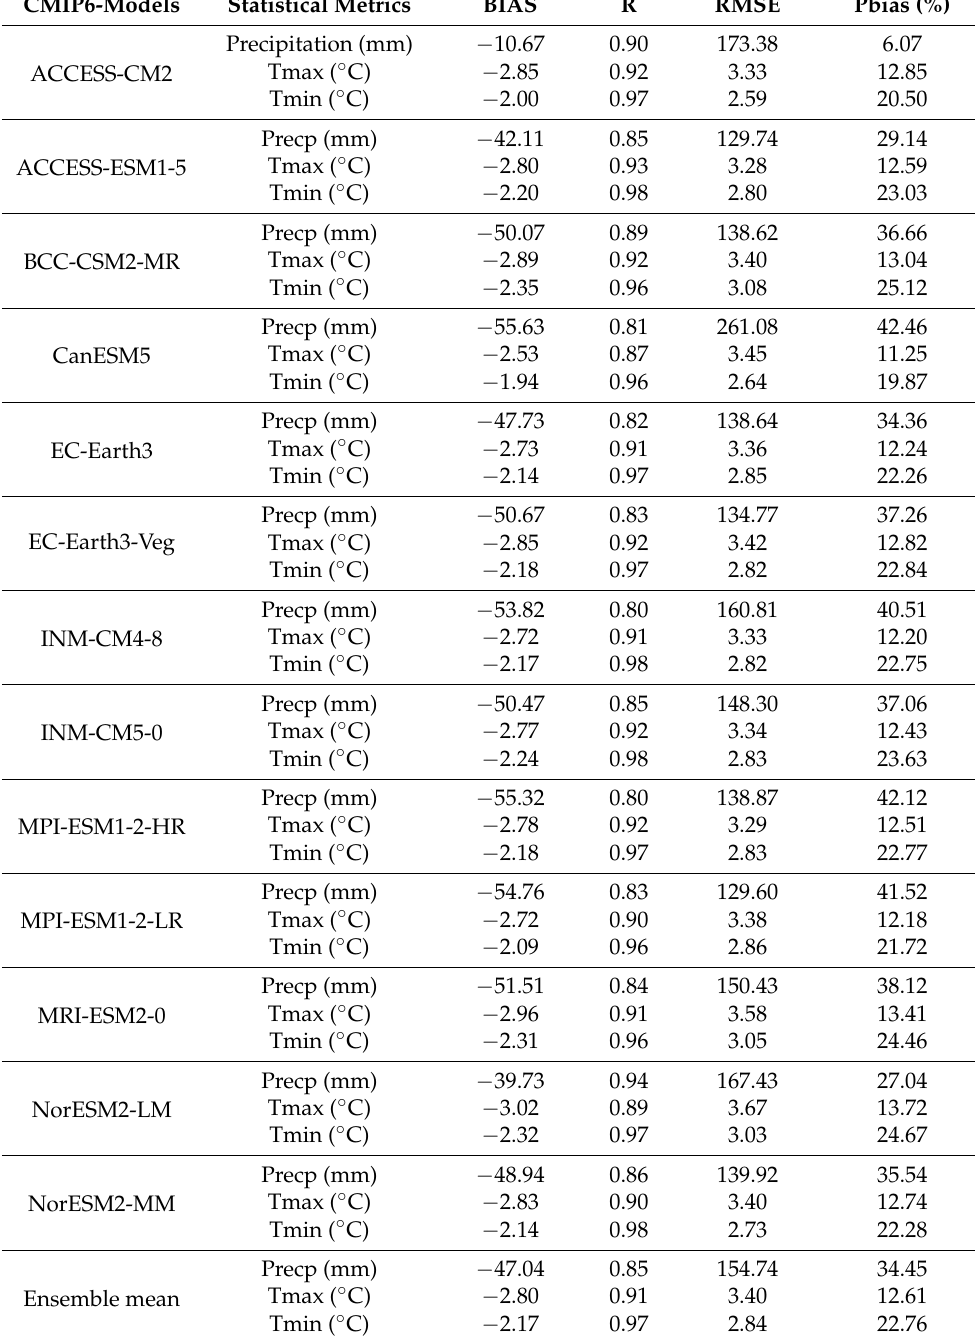
Table A1. Statistical metrics to quantify the performance of 13 bias corrected CMIP6